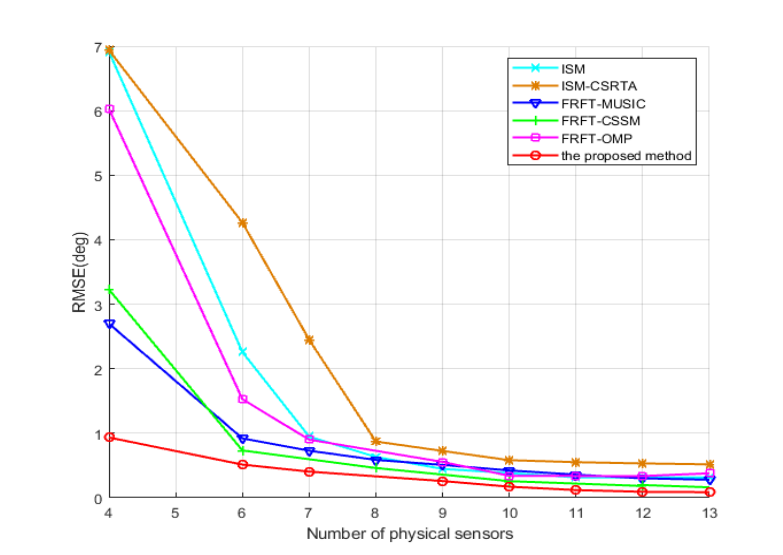
Figure 9. RMSE of the DOA estimations vs. number of physical sensors.